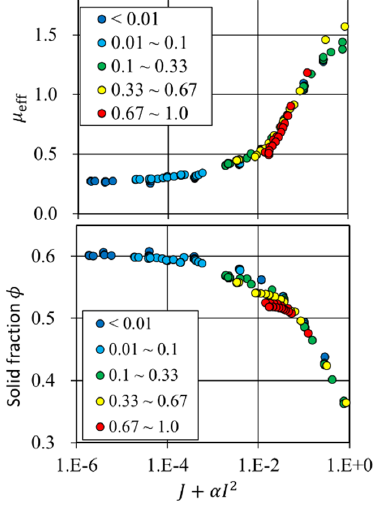
Fig. 5. Data from shear simulations using inputs in Table 2; Legend presents values of I (Eqn. ( 6)) for the data.